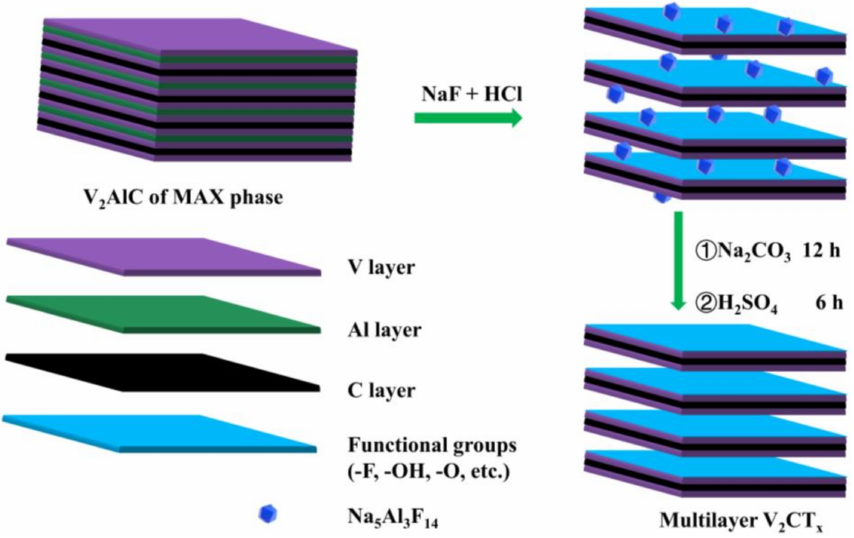
Figure 1. Schematic diagram of V 2 C synthesis